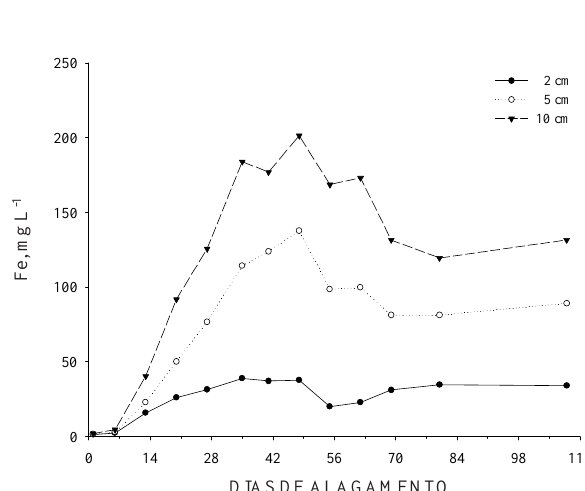
Figura 4. Concentração de ferro na solução do solo em três profundidades de um Planossolo submetido a